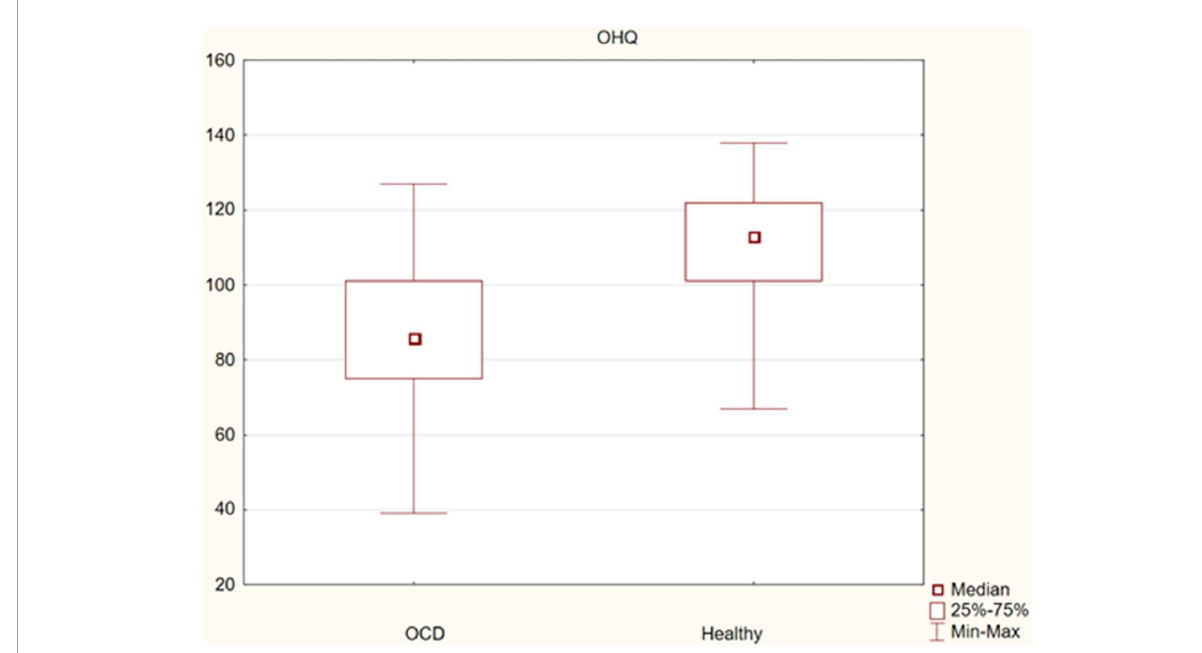
FIGURE1 Differences in happiness between obsessive-compulsive disorder (OCD) patients and healthy controls.